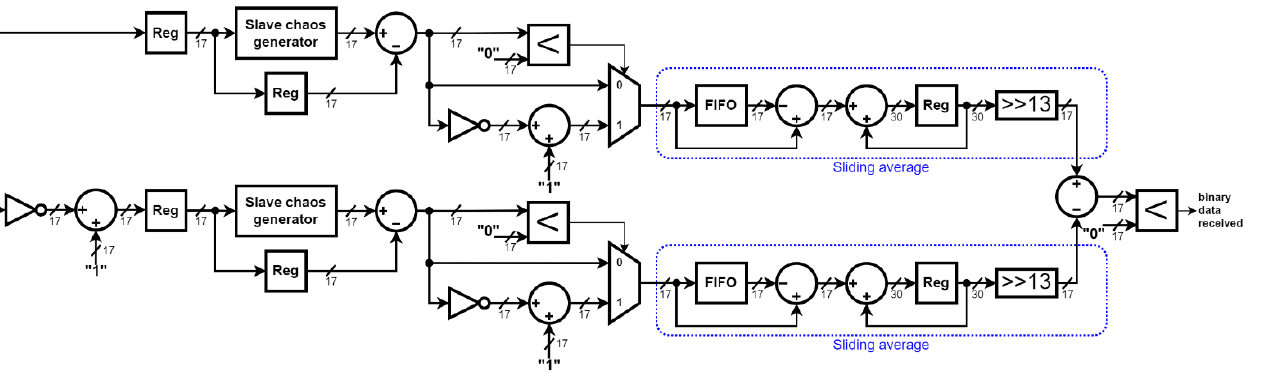
Figure 17. ACSK demodulator structure.